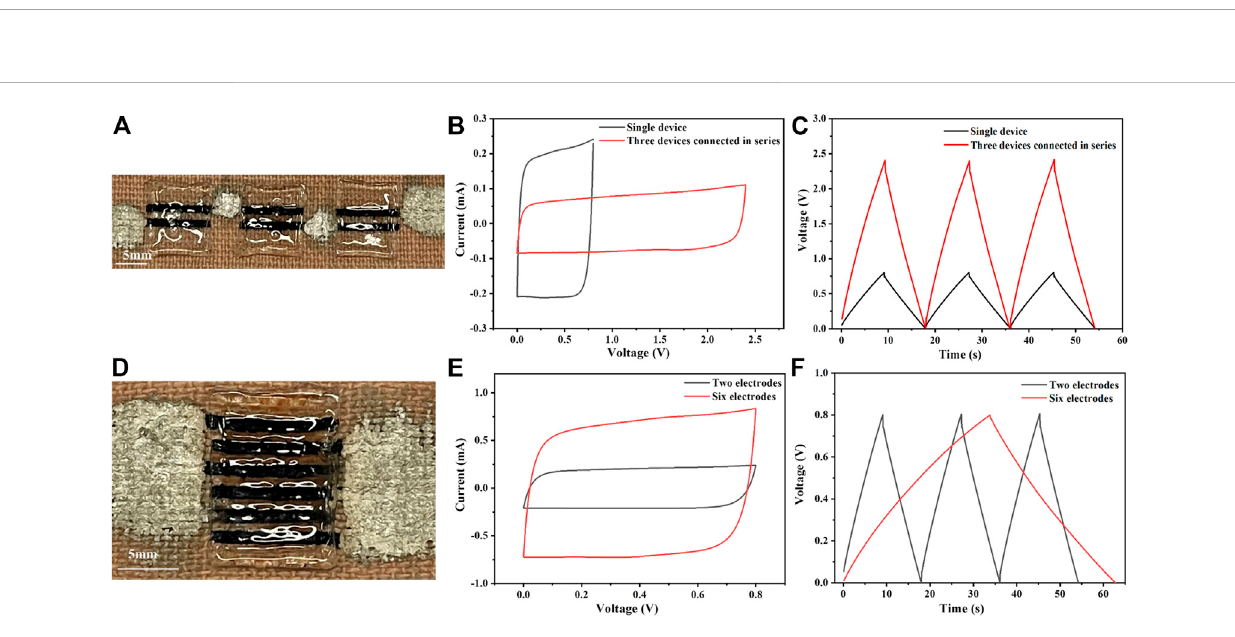
FIGURE 7 (A) Photo of three MSCs connected in series. (B) CV curves (100 mV s − 1 ) of a single MSC and three MSCs connected in series. (C) GCD curves of a single MSC and three MSCs connected in series at the current of 0.2 mA. (D) Photo of a MSC with 6 planar electrodes. (E) CV curves (100 mV s − 1 ) of the MSCs with 2 and 6 planar electrodes. (F) GCD curves of the MSCs with 2 and 6 electrodes at the current of 0.2